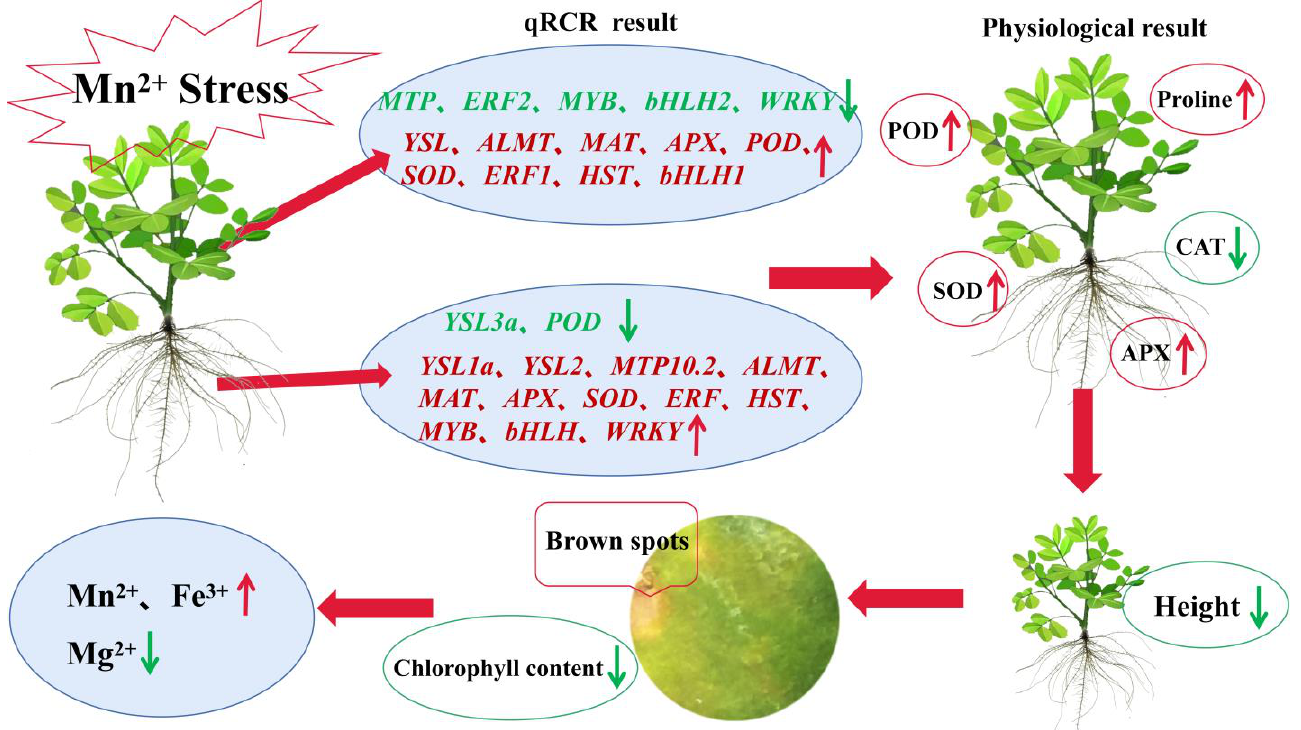
Figure 5. Regulatory processes of peanut roots and leaves in response to Mn toxicity stress. The small red arrows in the graph indicate up-regulation of gene expression or increasing in enzyme activity or substance content, while the small green arrows indicate down-regulation of gene expression or decreasing in enzyme activity or substance content.